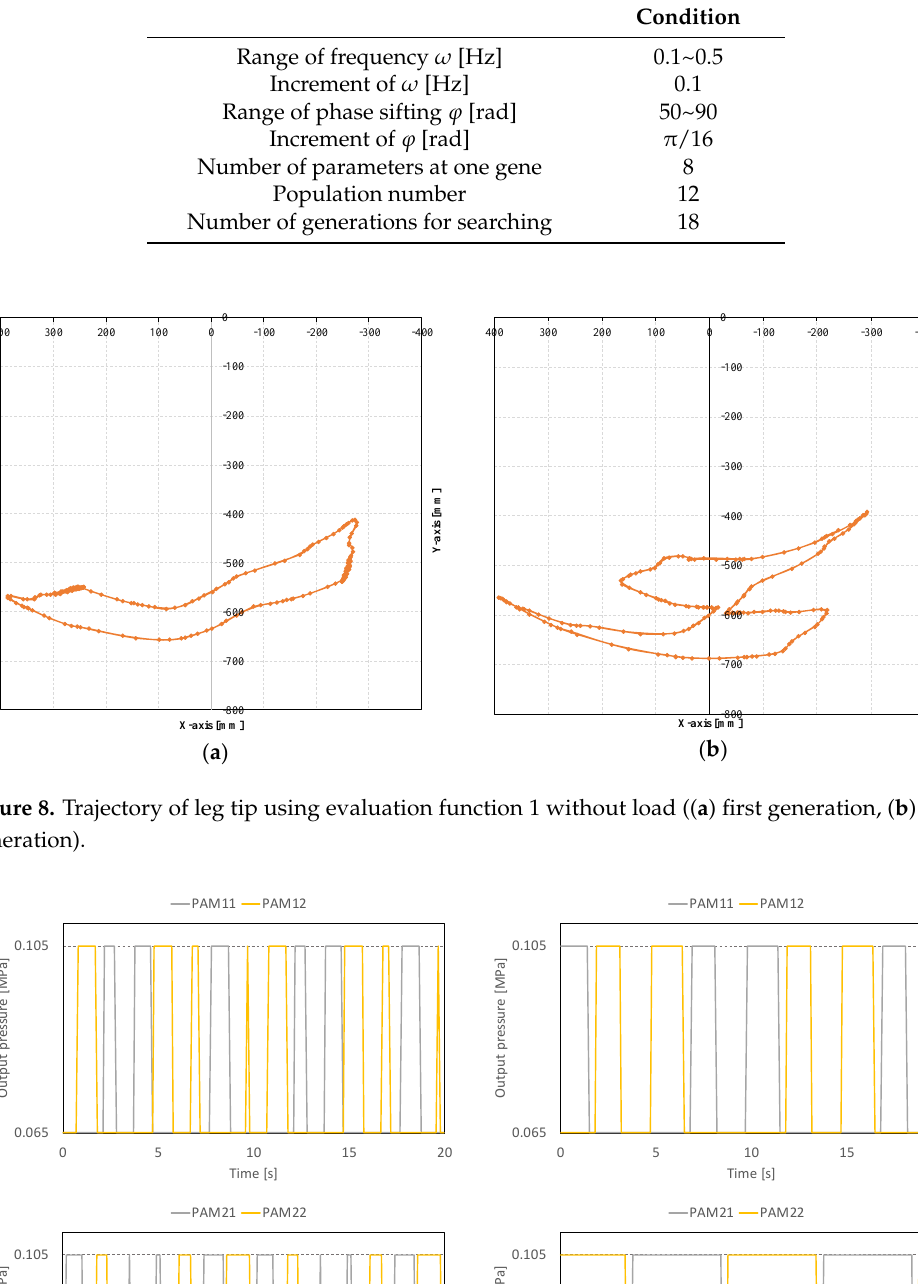
Table 2. Experimental conditions.